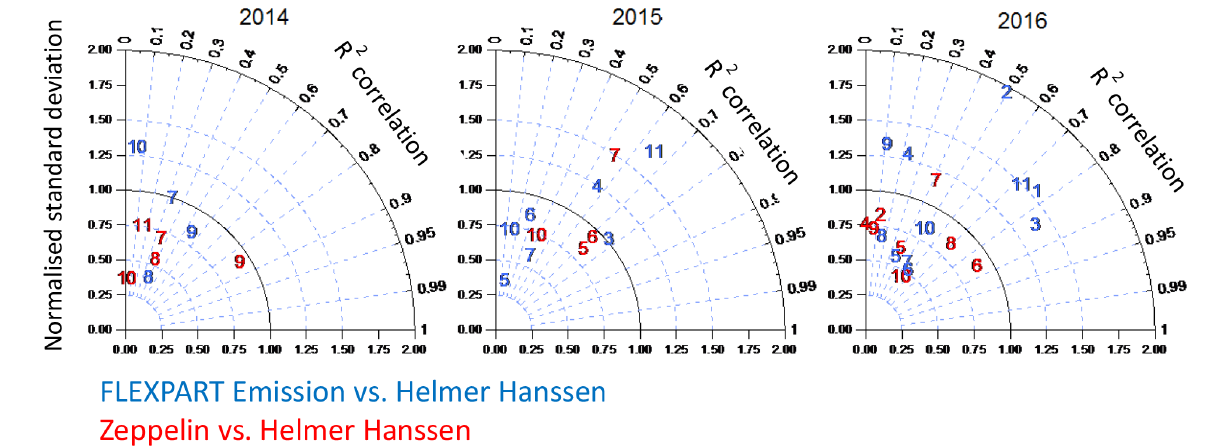
Figure 7. Taylor diagrams showing the monthly R 2 correlation (angle) and normalized standard deviation (radial axis) of modelled CH 4 emissions (blue) and CH 4 observed at Zeppelin Observatory (red, only for ship positions within 75–82 ◦ N, 5–35 ◦ ) compared to the RV Helmer Hanssen CH 4 time series. Numbers refer to month of the year. Ideal agreement would be found at 1 on the radial axis (black line) and 1 on the angular